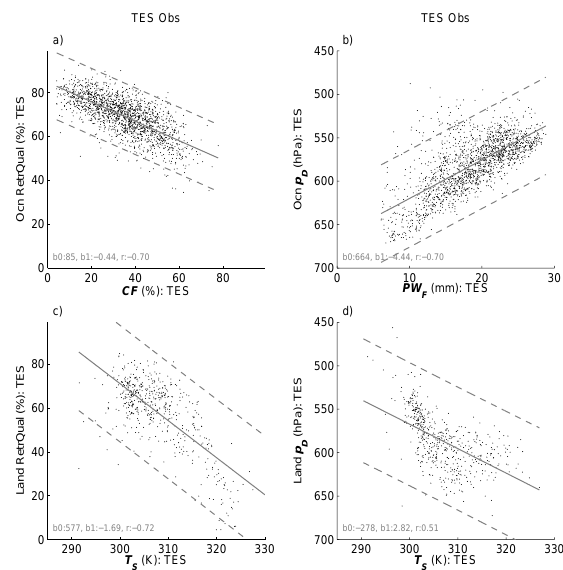
Fig. 4. TES retrieval quality (left) and p D (height of peak HDO sen- sitivity, right) as a function of primary control variables identified in Table 1 over ocean (top) and land (bottom). Dashed lines show the 95% prediction